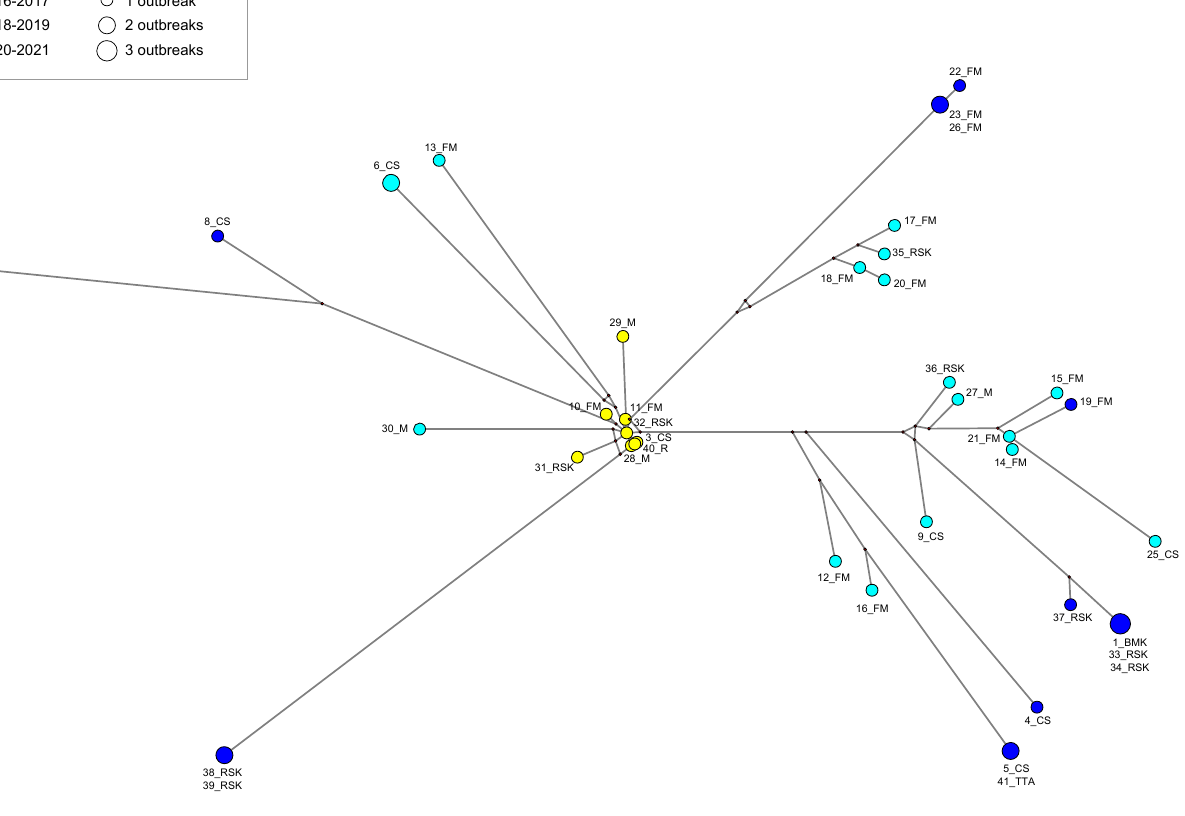
Figure 3. The HA median-joining network showing high genetic relationship between all 2016 and 2017 H9N2 Moroccan viruses while the viruses of 2018–2019 and 2020–2021 are separated from their 2016–2017 ancestors by long